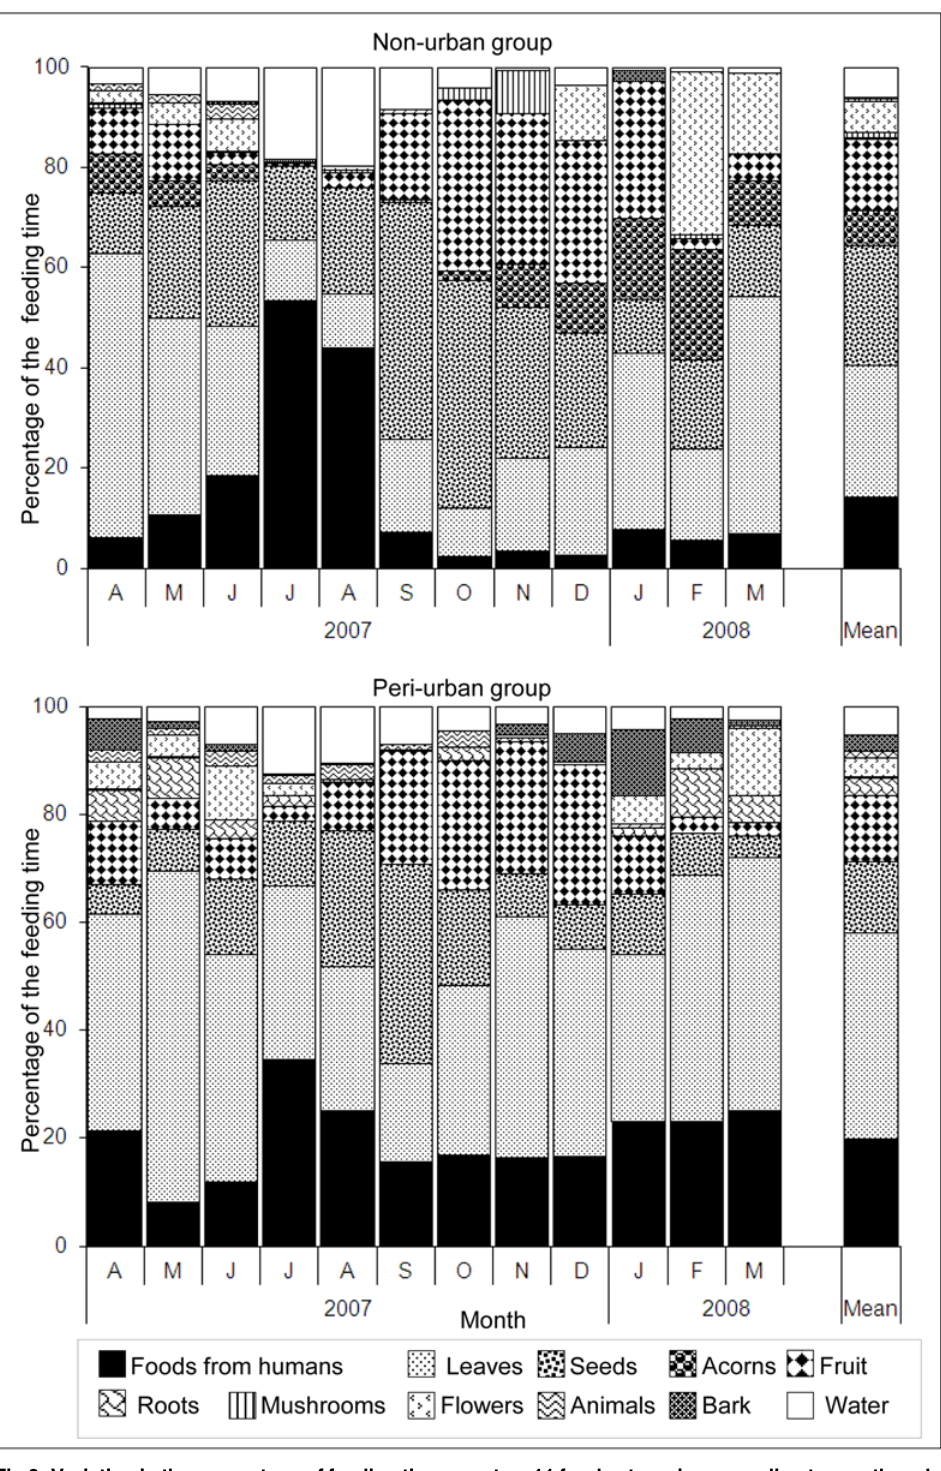
Fig 6. Variation in the percentage of feeding time spent on 11 food categories according to month and group. Leaves also included stems.